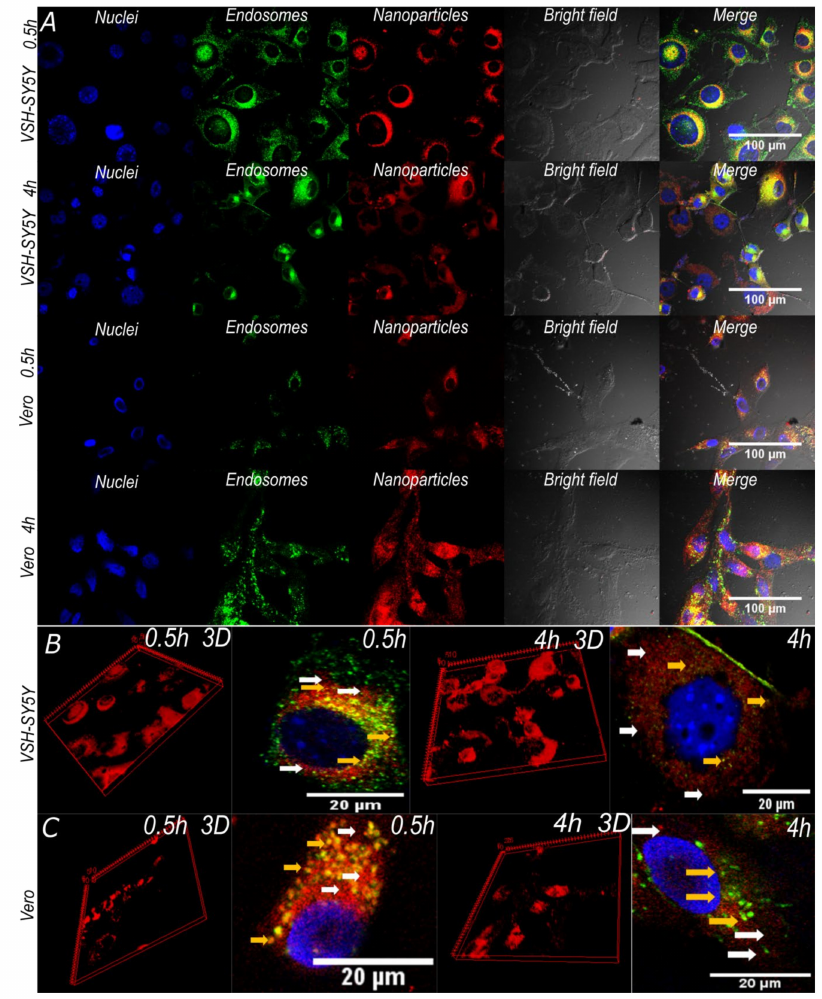
Figure 7. Confocal images of SH-SY5Y and Vero cells exposed to magnetite / silver-pDMAEMA-PEA- BUFII-RhodB nanobioconjugates for 0.5 and 4 h. ( A ) The first two channels correspond to nuclei (blue) and endosomes (green) labeled with Hoechst 33342 and Lysotracker green DND-26, respectively. The third channel corresponds to nanobioconjugates labeled with rhodamine-B (red) and the fourth to the DIC field that shows cell morphology and integrity. Finally, the merge of all channels’ highlights nanoparticle cellular internalization (yellow areas correspond to colocalization between red and green channels). ( B , C ) SH-SY5Y and Vero cells exposed to magnetite / silver-pDMAEMA-PEA-BUFII-RhodB nanobioconjugatesfor0.5hand4h. The3Dreconstructionsshowthedistributionofthenanobioconjugates throughout the cells’ cytoplasm. The white arrows point to endosomal escape areas (red areas), while the yellow ones showed colocalization of the nanobioconjugates and endosomes where no endosomal escape was achieved (yellow